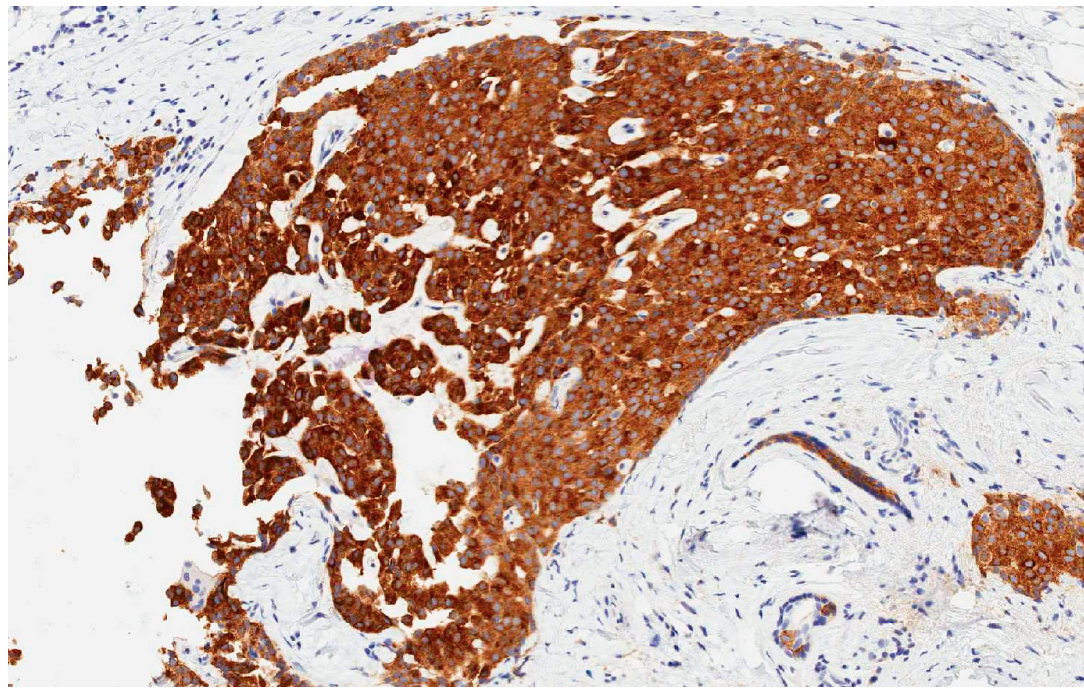
Figure 2. Immunohistochemistry (ICH): neuroendocrine tumor of the breast. Strong immunohistochemical expression of synaptophysin (40×).